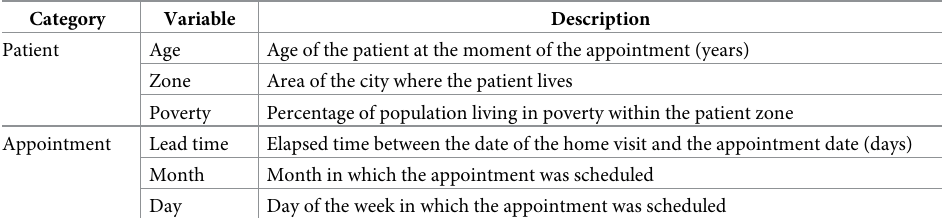
Table 1. Variables used for prediction